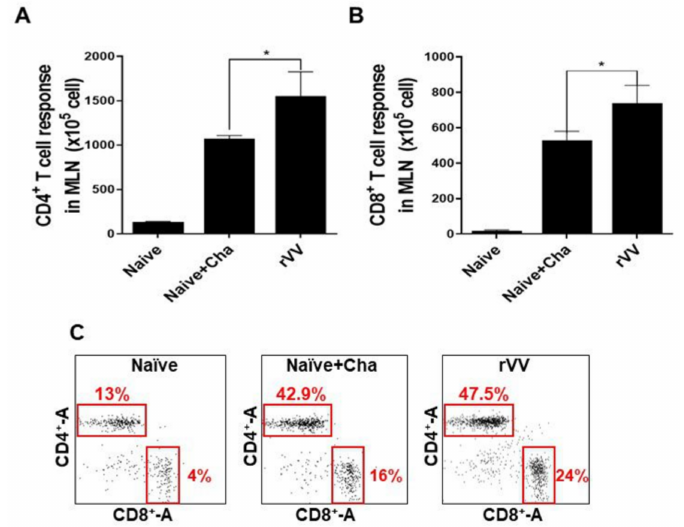
Figure 5. ROP4-rVV enhances T cell inductions in the MLNs of immunized mice. MLN cells of mice were collected. Single-cell populations of MLN cells were stimulated with T. gondii ME49 antigens. CD4 + ( A ) and CD8 + ( B ) T cells were quantified using flow cytometry. Representative scatterplots illustrating lymphocyte gating of the CD4 + and CD8 + T cells from 3 independent experiments were provided ( C ). Boxes indicate the percentages of both CD4 + and CD8 + T cells. Data are presented as mean ± SD from 3 independent experiments and asterisks denote statistical differences between groups (* p < 0.05).